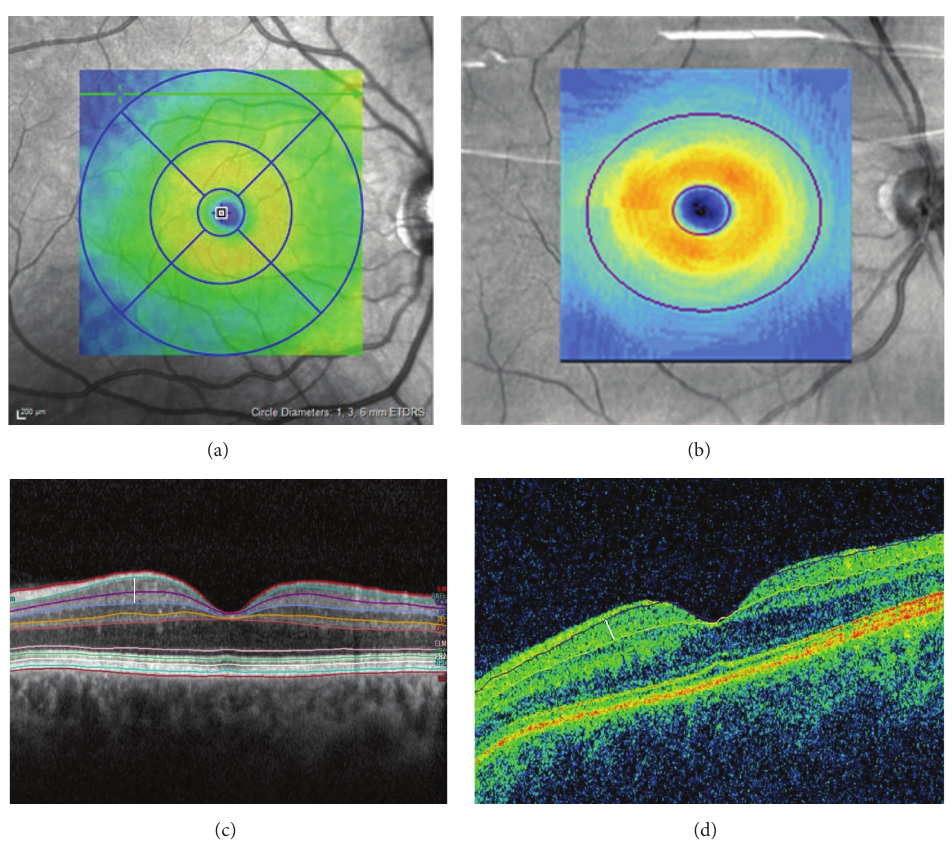
Figure 1: Top: (a) example from Early Treatment Diabetic Retinopathy Study (ETDRS) grid taken from Spectralis printout, used to calculate MT in both OCTs: scan area of 6 × 6mm, divided into three concentric circles with 1 mm, 3mm, and 6 mm diameter, respectively. Here, we used values from the 1 and 3 mm circles of the grid. (b) Area used in Cirrusto calculate GCIPL thickness corresponding to an elliptical annulus with a 2.0 mm vertical and 2.4 mm horizontal radius, excluding a central elliptical area (0.5 mm vertical and 0.6mm horizontal radius) that corresponded to the foveola; in Spectralis GCIPL thickness was calculated with values in the 3 mm circle from ETDRS grid, excluding the 1mm diameter circle. Bottom: OCT images using layer segmentation software from each instrument: (c) Spectralis, (d) Cirrus (same patient). While Cirrus software calculates only ganglion cell-inner plexiform layer (GCIPL) and excludes retina nerve fiver layer (RNFL), Spectralis software segments all retina layers and values from ganglion cell and inner plexiform layers were added manually. The white bar represents limits for thickness measurement of ganglion cell-inner plexiform layer in Spectralis (left) and Cirrus